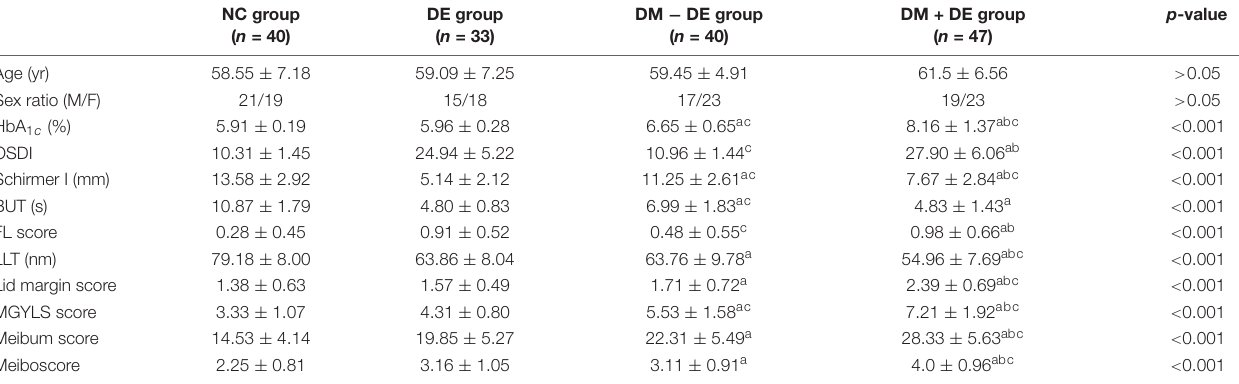
TABLE 3 | Tear film and meibomian gland parameters in patients with T2DM with or without dry eye.